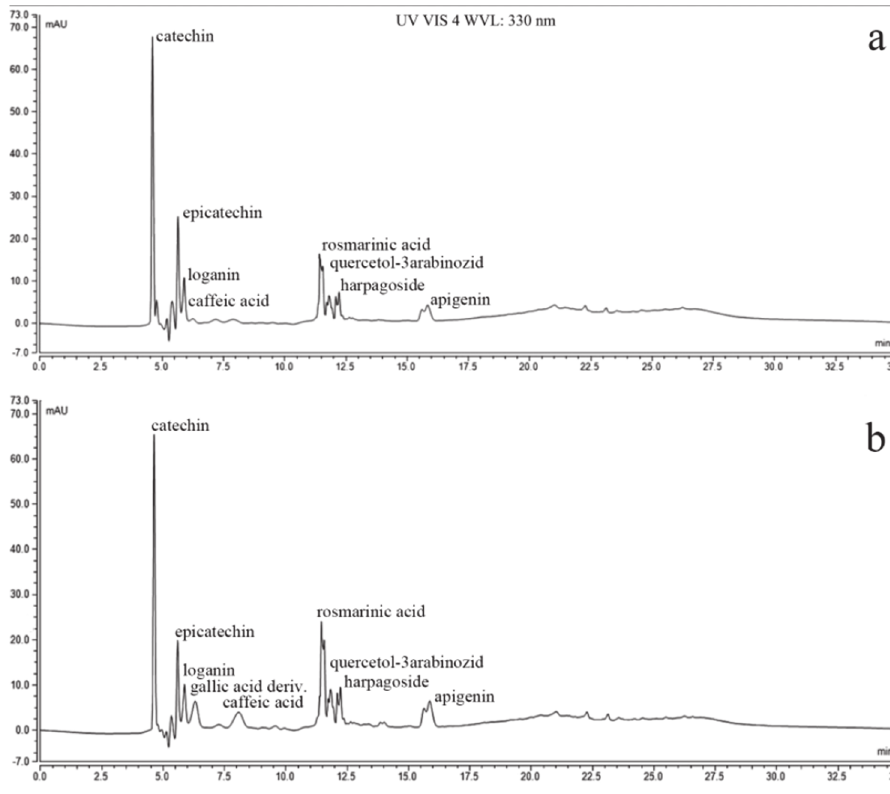
Figure 1. Chromatograms of Polyalthia longifolia leaf extracts PlLm ( a ) and PlLe ( b ).